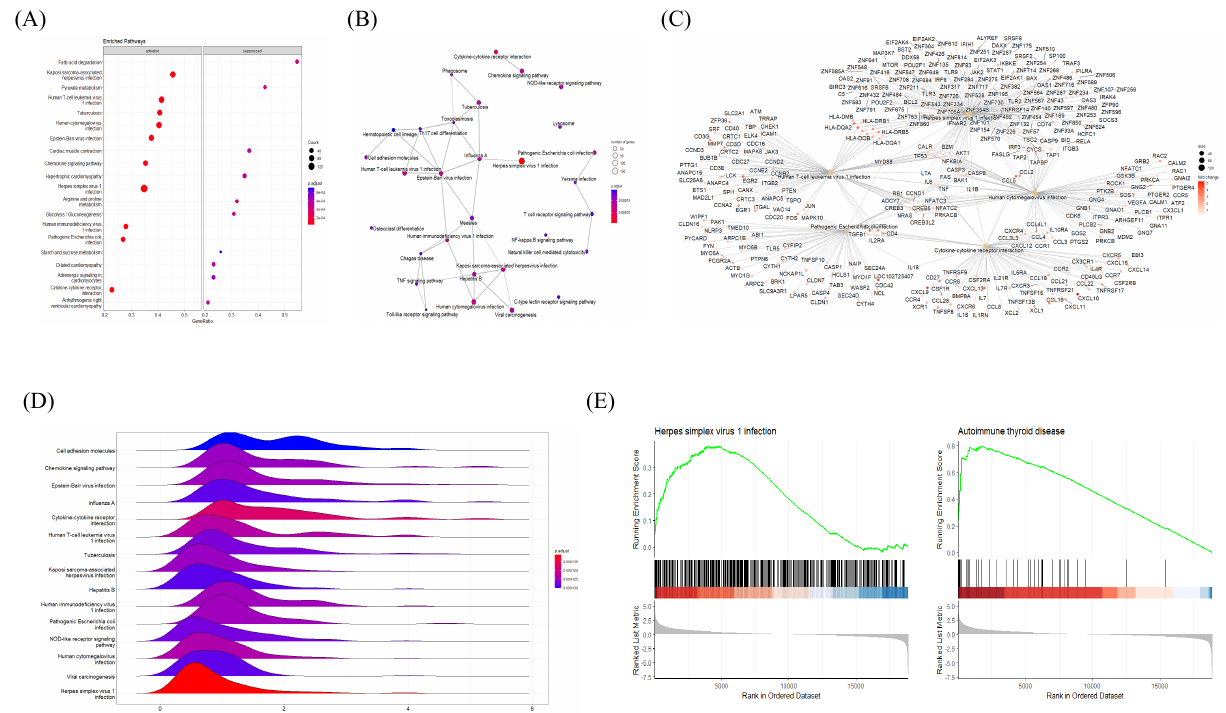
Figure 5. Gene Set Enrichment Analysis (GSEA) plots of KEGG pathways enriched in HT samples. ( A ) Bubble plot of KEGG pathways, ( B ) Emapplot, ( C ) Cnetplot, and ( D ) Ridgeplot analyzed with ranked DEGs of the HT group from microarray data. ( E ) GSEA KEGG plot with ranked DEGs of the HT group from microarray data. All plots were created by using the clusterprofiler R